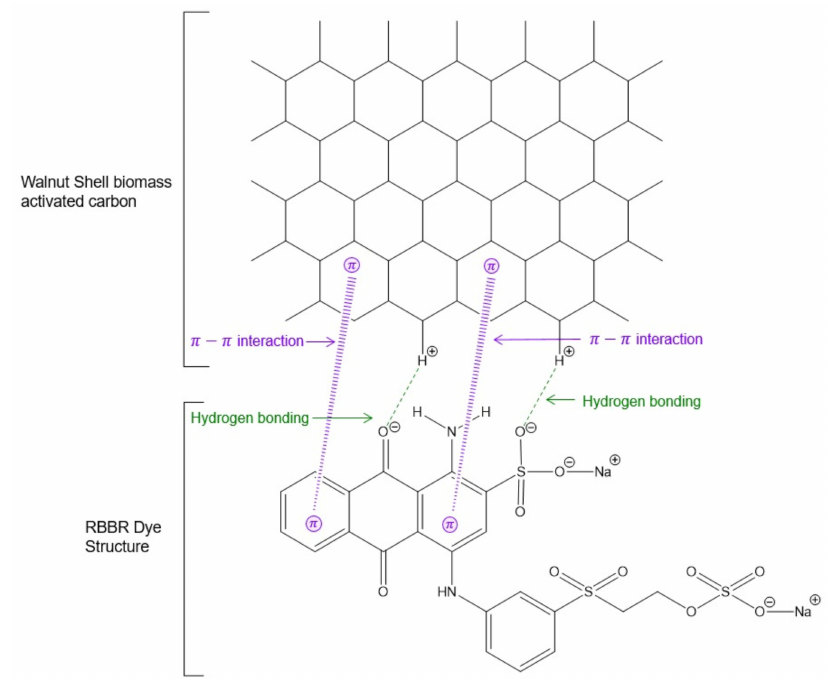
Figure 15. Proposed mechanism for RBBR dye adsorption onto WSBAC